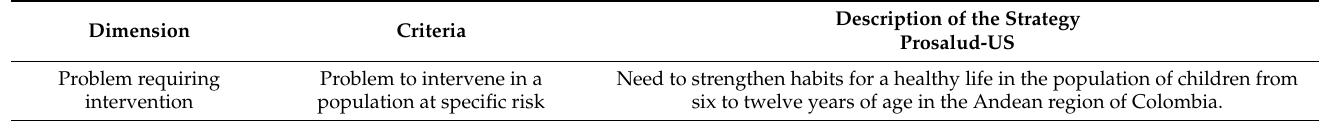
Table 1. Design criteria for the health promotion strategy “Prosalud” with schoolchildren in the Andean region of Colombia, 2018–2021, under the application of the Whittemore and Grey parame- ters